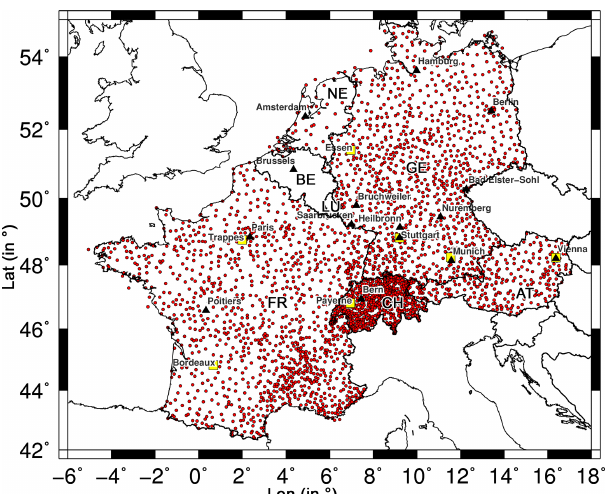
Figure 1. All considered precipitation stations (in red) collected from ECA&D and the three national weather services (France, Ger- many, Switzerland; see Sect. 2.1.3). In addition, the seven investi- gated sounding stations are shown (in yellow; see Sect. 2.1.5). Some relevant locations are also presented, as they are used in the text. De- fined country codes are FR (France), BE (Belgium), NE (Nether- lands), LU (Luxembourg), GE (Germany), CH (Switzerland), and AT